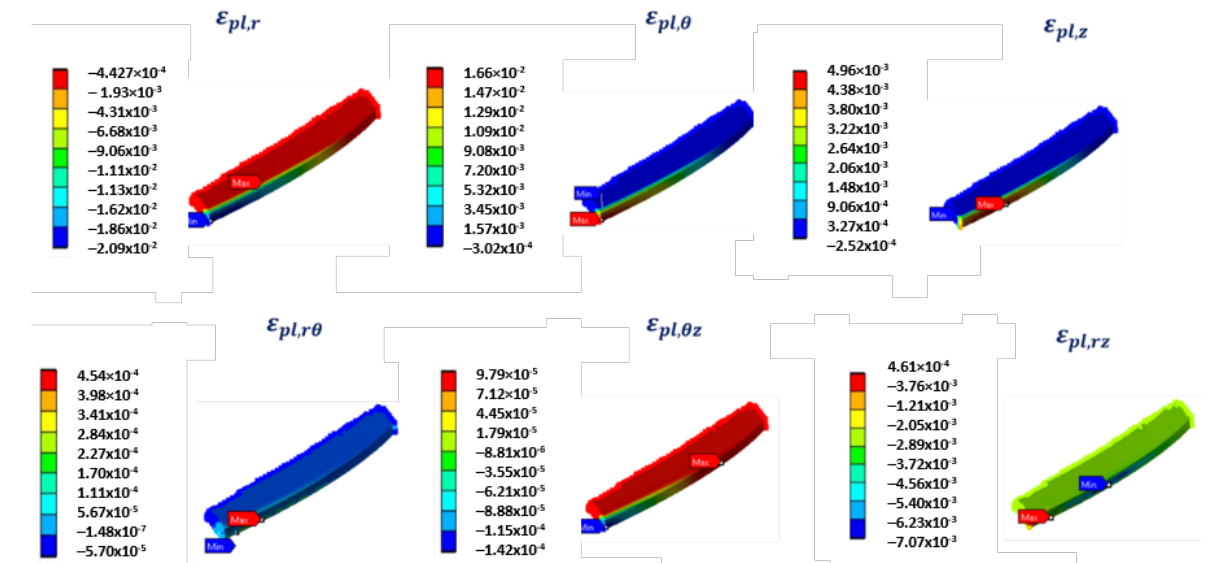
Figure 14. Plastic strains at the end of the ignition phase.